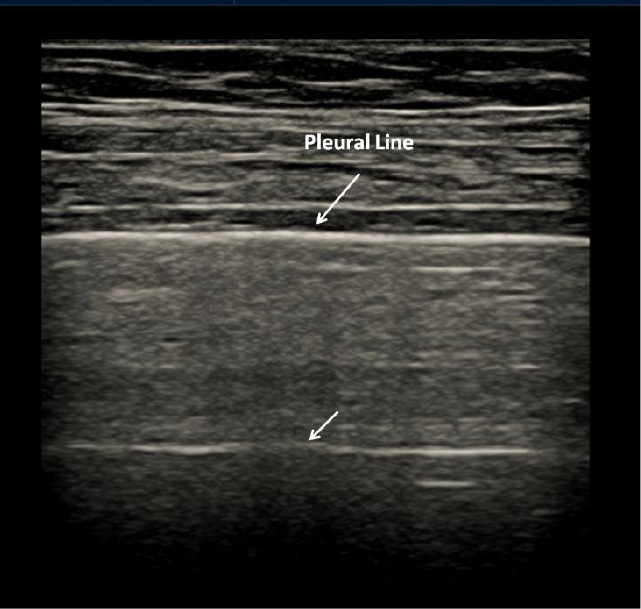
Figure 1. Normal lung. Pleural line is regular. The first artefactual replica of the pleural line is clearly seen (deeper arrow). Between the pleural line and the first A-line, a blurred superposition of the parietal acoustic discontinuities appears due to the mirror and replica effects caused by the strong reflection of the pleural line. Linear probe, 8 MHz.